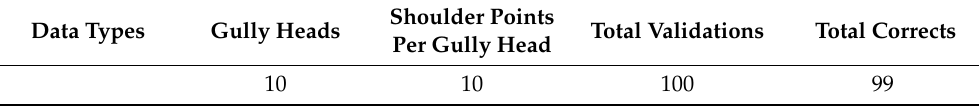
Table 2. Measured data verification.